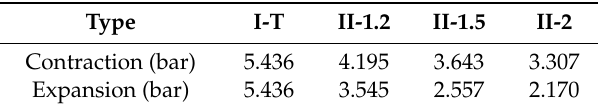
Figure 10. Pressure and velocity along passages II: ( a ) contraction and ( b ) expansion. Table 3. Pressure drop in contraction / expansion.